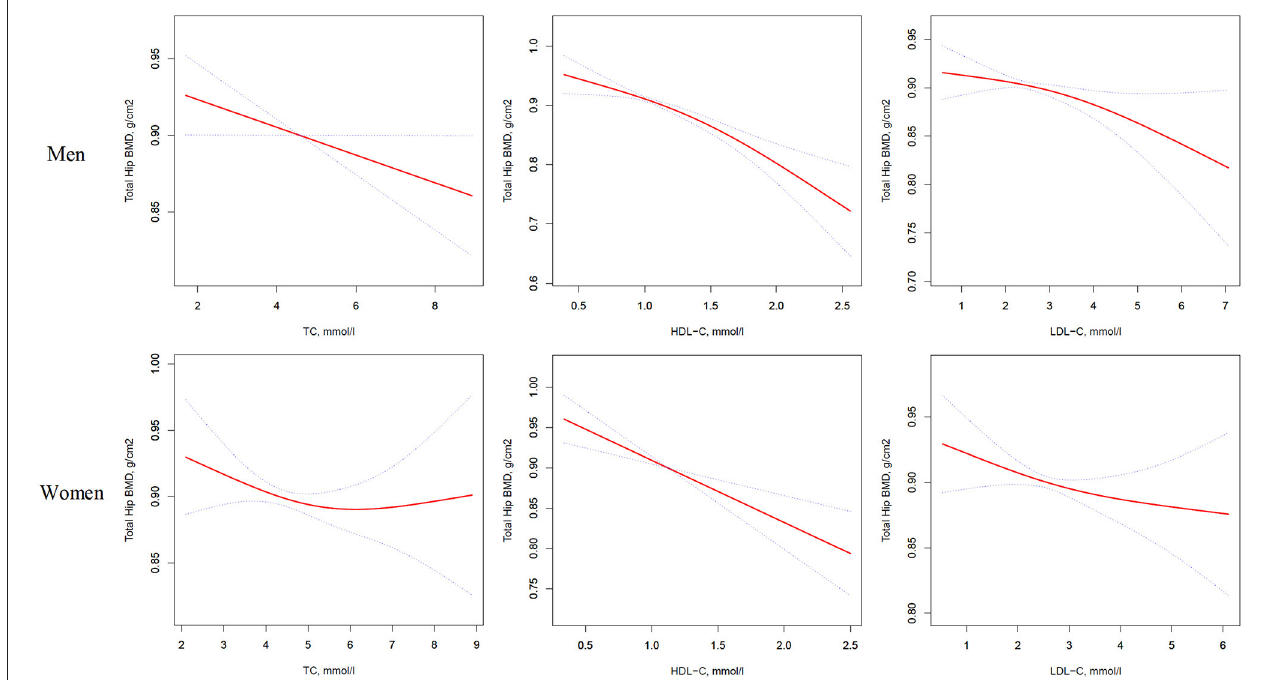
FIGURE 3 | Multivariate adjusted smoothing spline plots of total hip BMD by TC, HDL-C, and LDL-C. Red dotted lines represent the spline plots of TC, HDL-C, and LDL-C and blue dotted lines represent the 95% CIs of the spline plots. Adjusted for age; diabetic duration(y); treatment of DM; smoking; drinking; BMI; cerebrovascular disease; kidney disease; family history of DM; diastolic blood pressure; FBG, unit; Cr, umol/l; BUN, mmol/l; Ca, unit; ALT, U/L; AST, U/L; ALP, U/L.